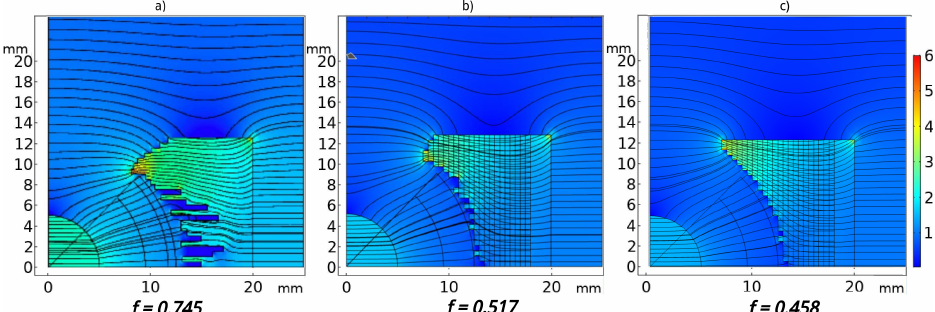
Figure 11. Optimal geometries and flux density norm. Cases ( a – c ) correspond, respectively, to the full FEA-based optimization, the previous work [7] and the proposed solution in this work.